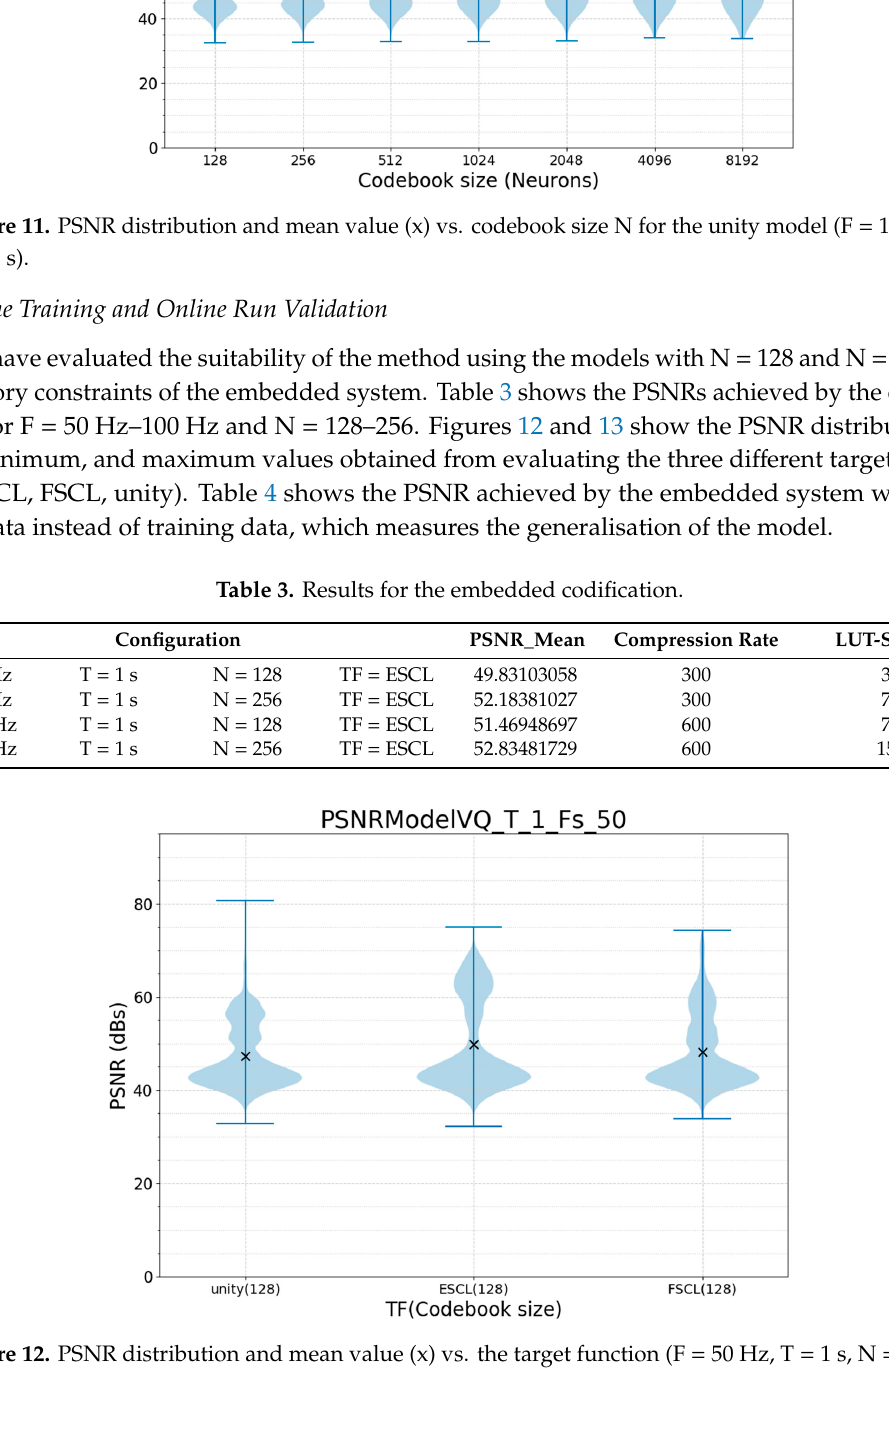
Figure 11. PSNR distribution and mean value (x) vs. codebook size N for the unity model (F = 100 Hz, T = 1 s).